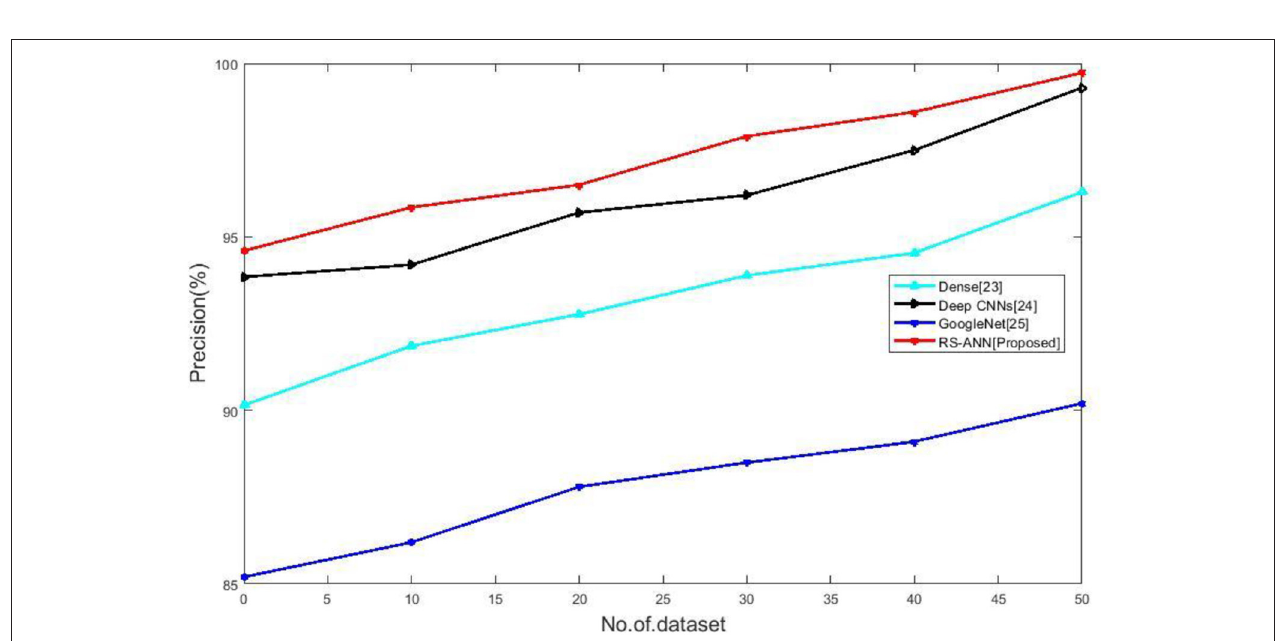
FIGURE 3 | No of dataset vs. accuracy.